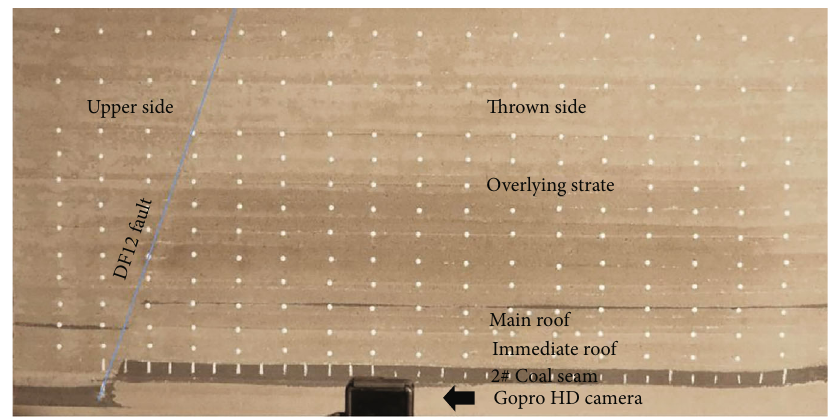
Figure 7: Similar simulation experiment